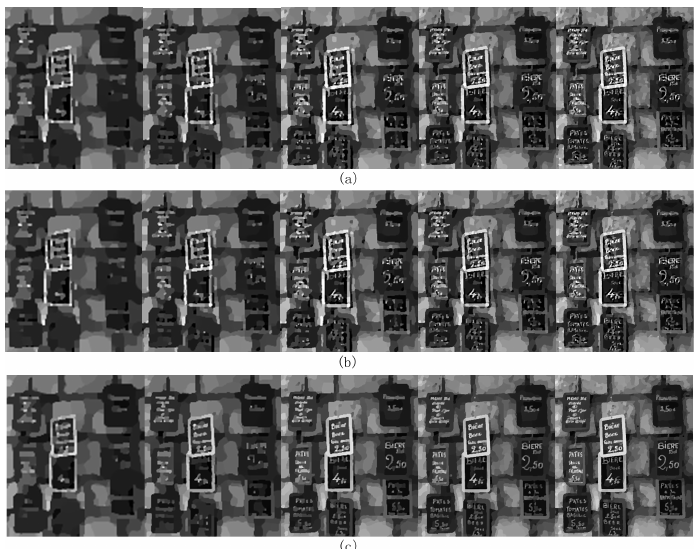
Figure 10. Visual comparison of the intermediate results generated during iteration. ( a – c ) are intermedi- ate results generated during iteration using the DCP, ECP and our sparse channel prior, respectively.